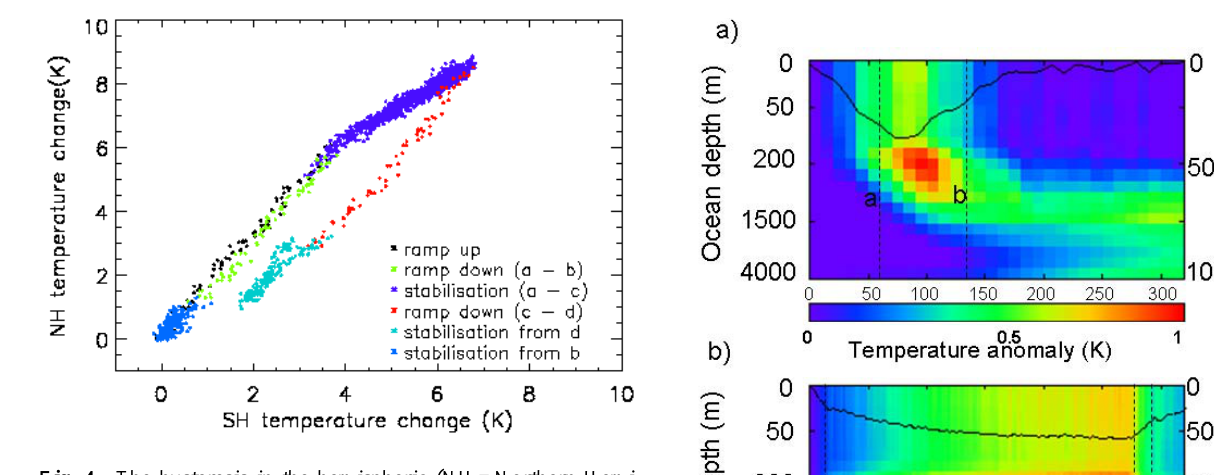
6 Figure 4. The hysteresis in the hemispheric (NH=Northern Hemisphere, SH=Southern Fig. 4. The hysteresis in the hemispheric (NH=Northern Hemi- sphere, SH=Southern Hemisphere) near-surface air temperature.